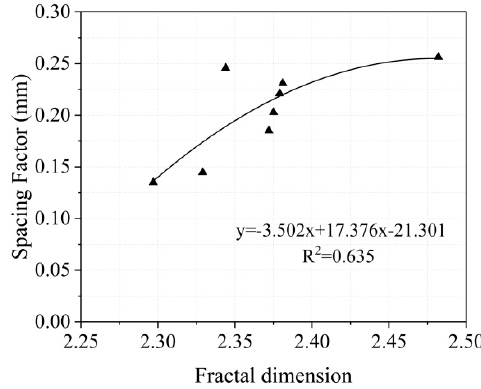
Figure 9. Fitting of spacing factor and fractal dimension.